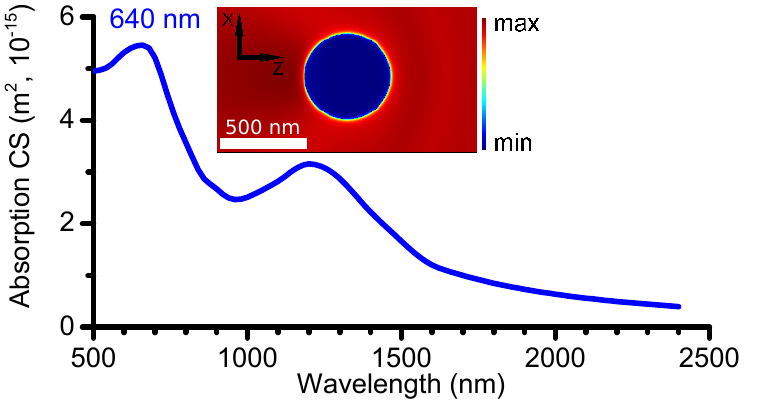
Figure 1. Simulated absorption cross-section (CS) of Ti 3 C 2 T x disk of diameter 500 nm with 14 nm height. Inset: electric field intensity map at IBT resonance—640 nm.